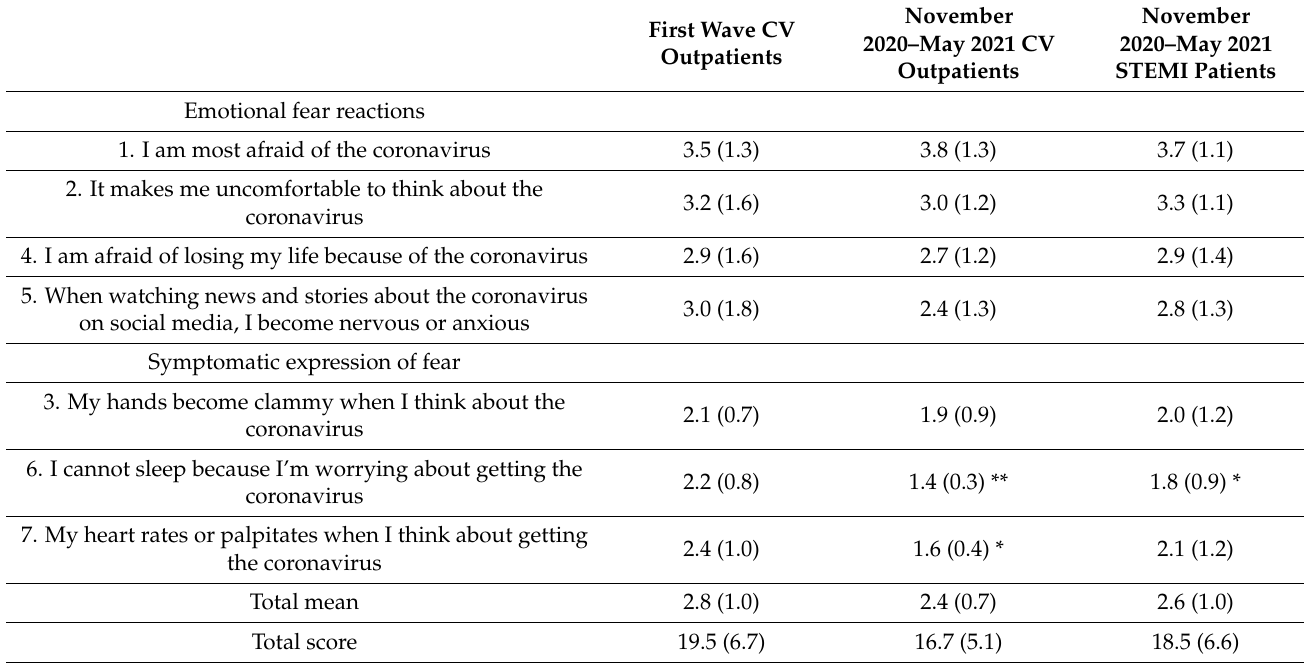
Table 2. Mean ( ± standard deviation) of the 7 items of the Italian Fear of COVID-19 score in CV outpatients during the